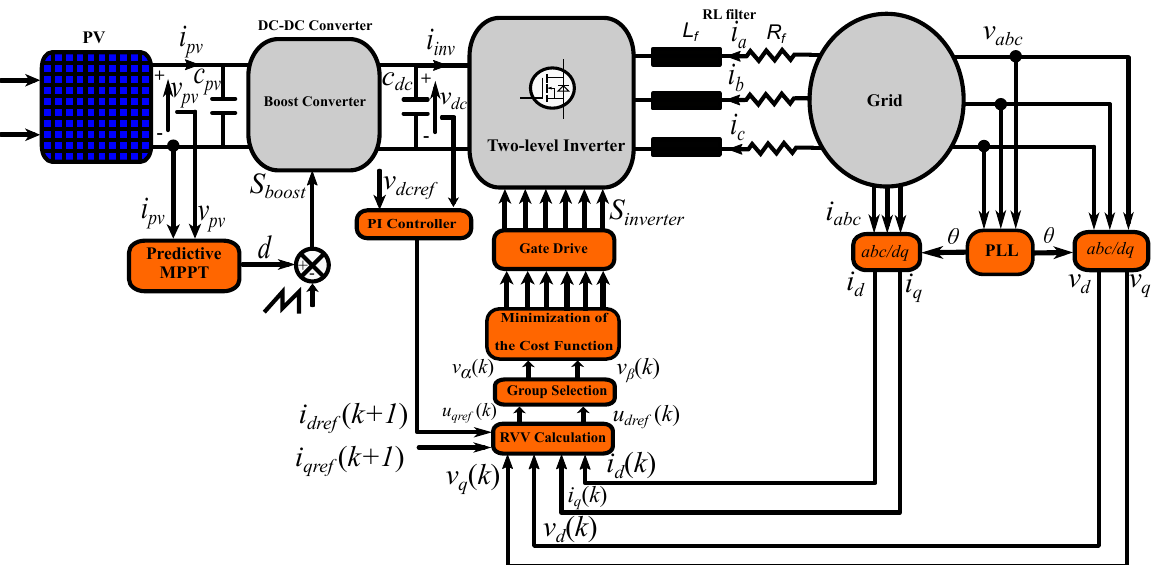
Figure 7. The configuration and proposed control strategy for the two-stage PV system.